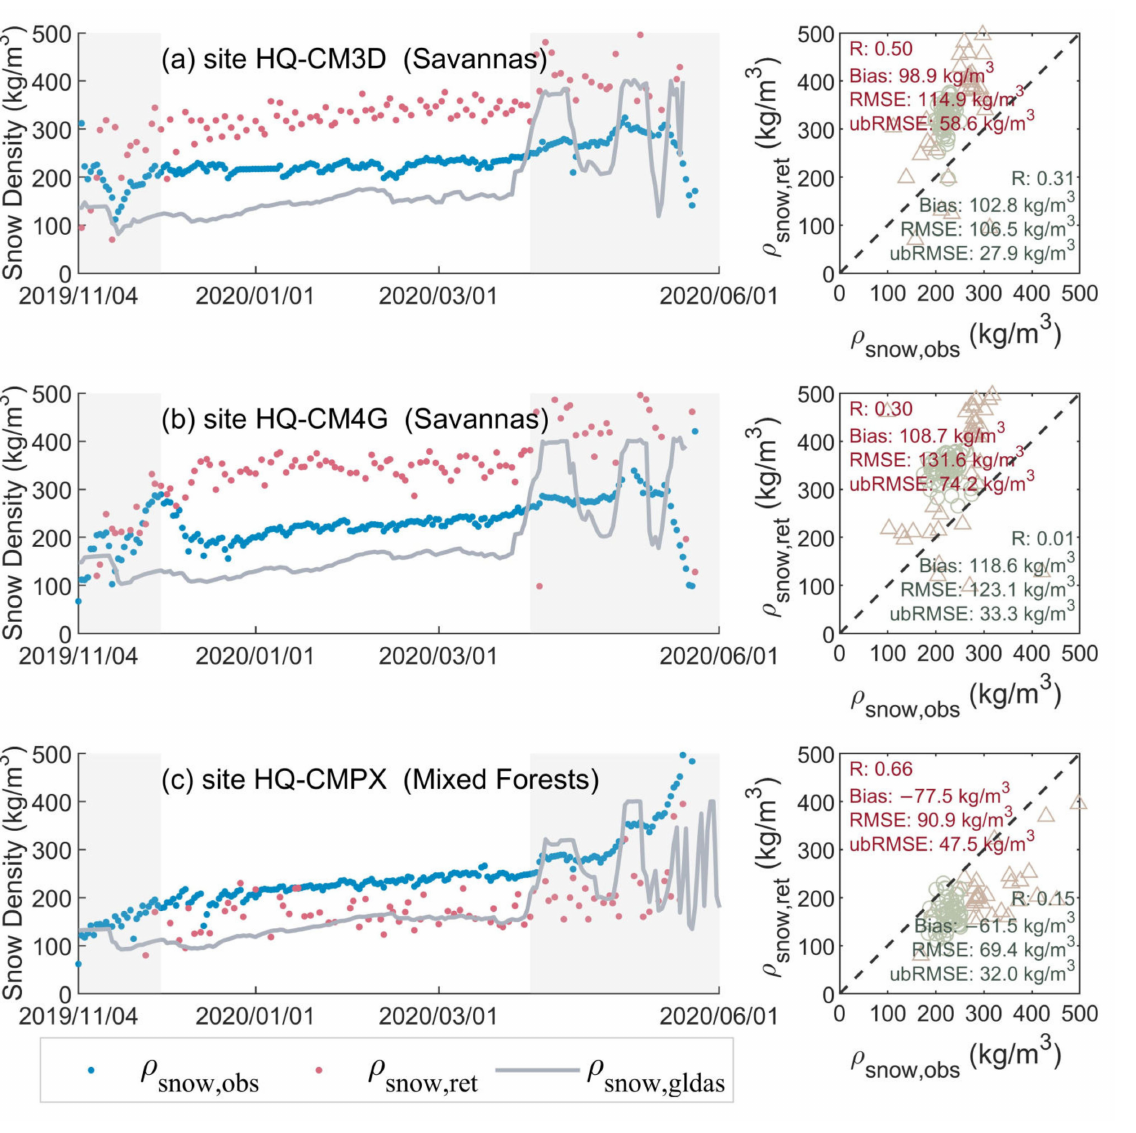
Figure 6. Time series (left) and scatterplots (right) of in-situ and retrieved snow density at the three stations with poor performance among 43 stations: ( a ) HQ-CM3D, ( b ) HQ-CM4G, ( c ) HQ-CMPX, compared with the GLDAS snow density. Labels and statistics in the right subplots are the same as those in Figure